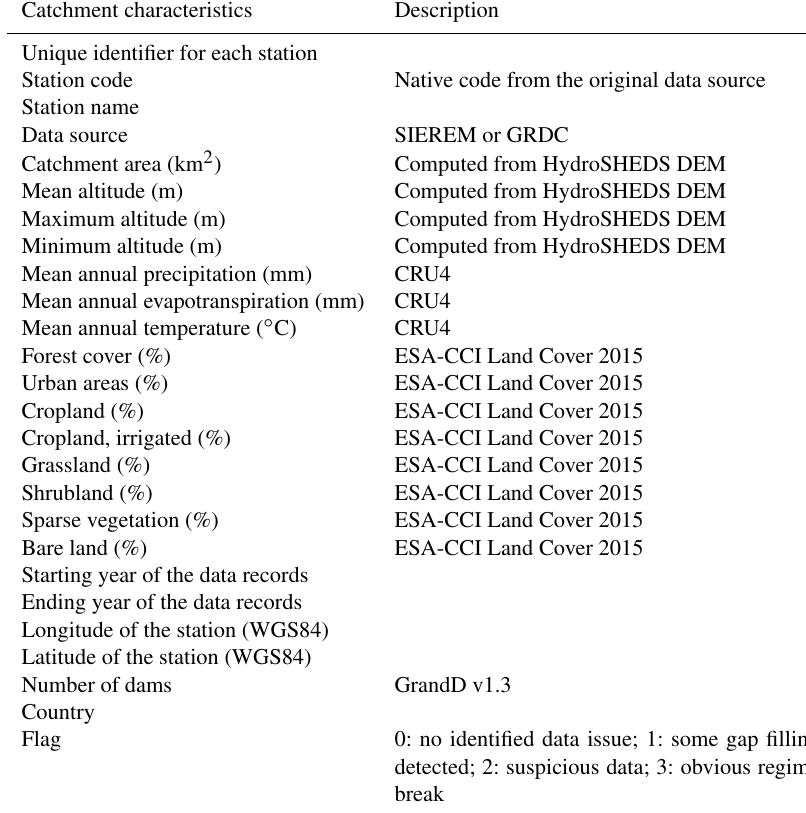
Table 2. Catchment metadata in the file